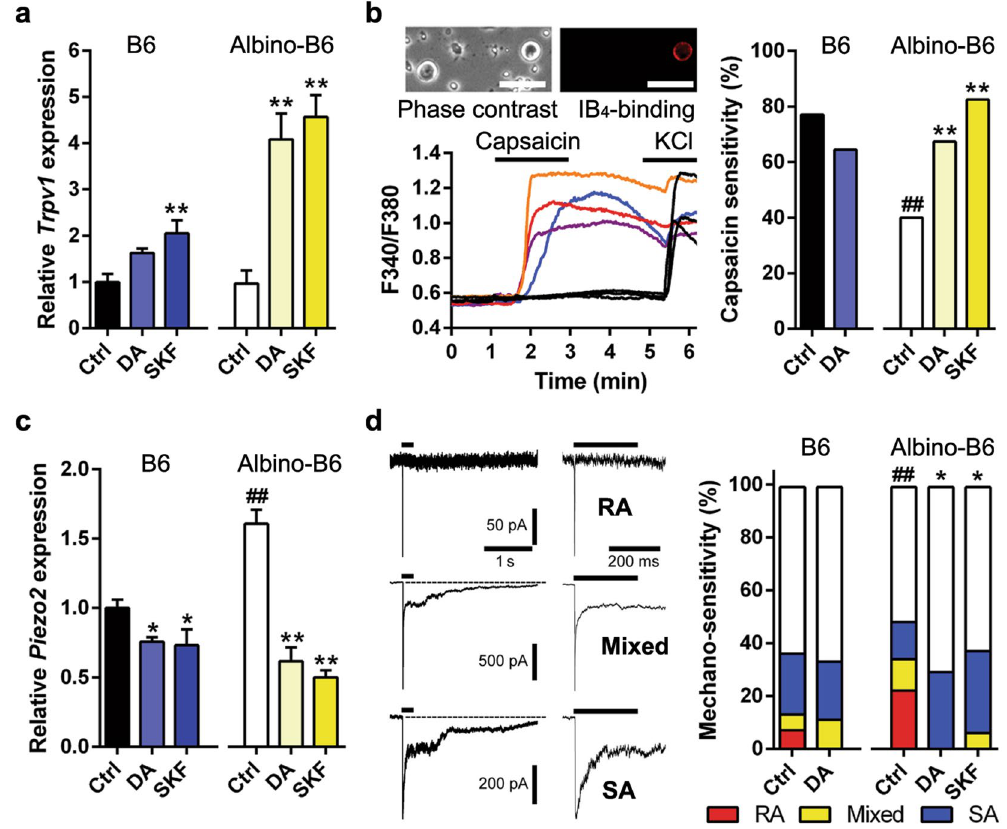
Figure 4. Dopamine modulates pain-related gene expression in sensory neurons. ( a ) Trpv1 levels in the trigeminal ganglion (TG) following repeated injection of PBS (control (Ctrl), n = 4), dopamine (DA, n = 6) or SKF39393 (SKF, n = 4). * P < 0.05, ** P < 0.01, vs control, in t -test. All bars show mean ± s.e.m. ( b ) Capsaicin sensitivity in IB 4 -positive TG neurons following Ctrl, DA (10 μ M) or SKF (30 μ M) incubation. Photomicrographs are representative phase contrast and IB 4 -fluorescence images. Scale bar, 50 μ m. Traces are representative Ca 2 + responses in TG neurons. Ctrl and DA in B6: n = 27/35 and 29/45, respectively. Ctrl, DA and SKF in albino-B6: n = 12/30, 37/55 and 33/40, respectively. ** P < 0.01, vs Ctrl, ## P < 0.01, vs B6, in Fischer’s test. ( c ) Piezo2 levels in the TG following repeated injection of PBS, DA or SKF. Sample preparation and analysis were the same as A . ## P < 0.01, vs B6. ( d ) Mechanically-activated currents (rapidly-adapted (RA), slowly- adapted (SA) and mixed types) in TG neurons following DA or SKF incubation. Two adjacent traces are same at different time ranges. Ctrl and DA in B6: n = 83 and 18, respectively. Ctrl, DA and SKF in albino-B6: n = 43, 17 and 16, respectively. * P < 0.05, vs Ctrl, ## P < 0.01, vs B6, in Chi-square